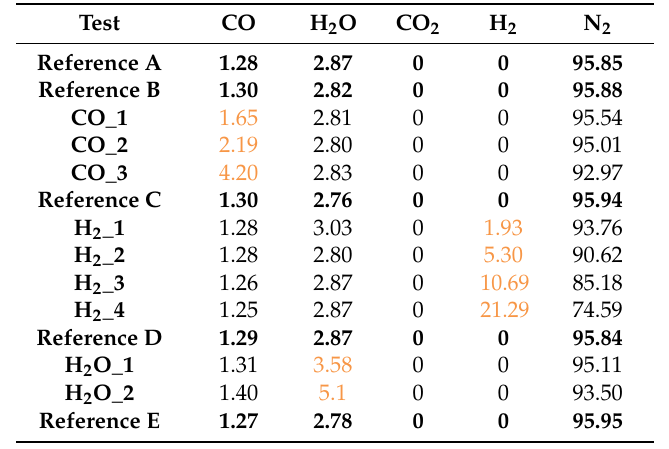
Table 1. Summary of feed composition (%) of the experiments for the kinetic